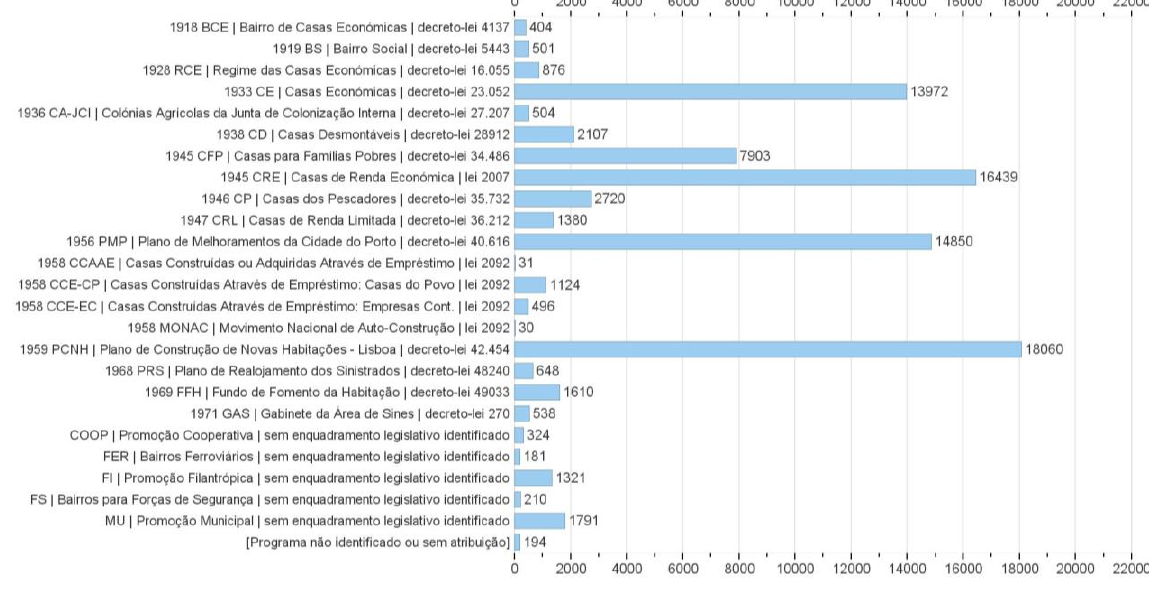
Figure A5. Linear chart. No. of built dwellings per housing programme. Source: MdH database, 2019. Universe: built